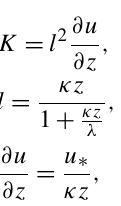
Table 1. The order of operation in the FORCAsT model. ∂C i